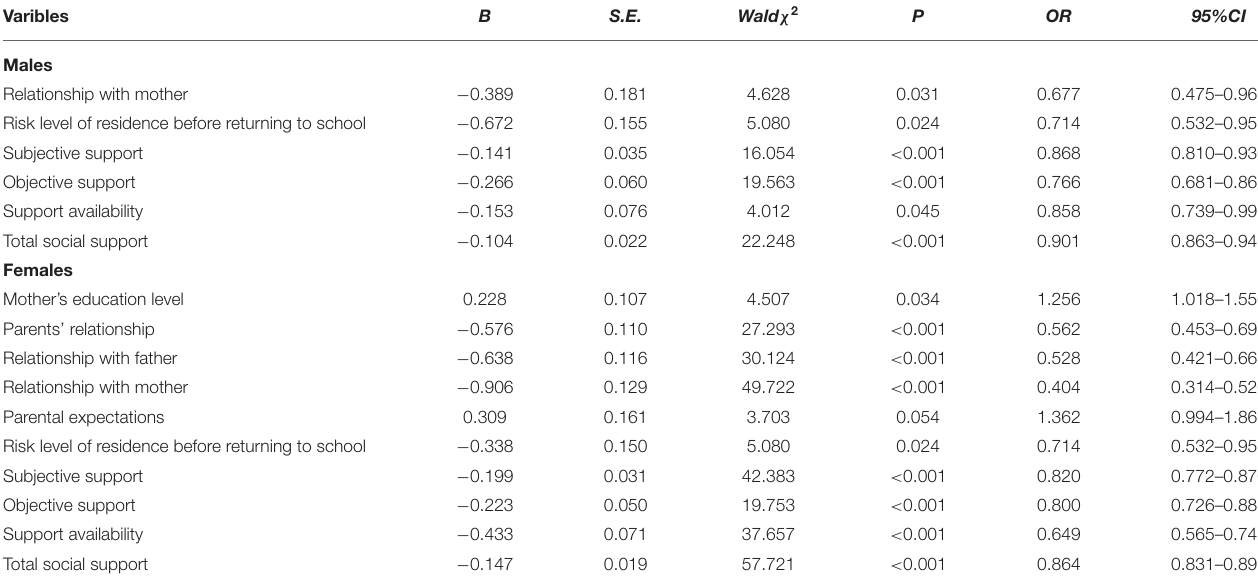
TABLE 2 | Univariate logistic regression analysis of suicidal ideation.